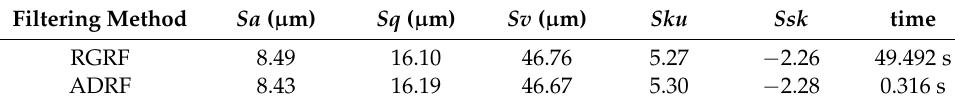
Figure 16. ( a ) Waviness surface and ( b ) roughness surface after using the ADRF filter. Figure 17. Material ratio curves after using the ADRF and RGRF filter. Table 8. Roughness parameter values after using the ADRF and RGRF filter. Filtering Method 0.316 s Figure 17. Material ratio curves after using the ADRF and RGRF filter.